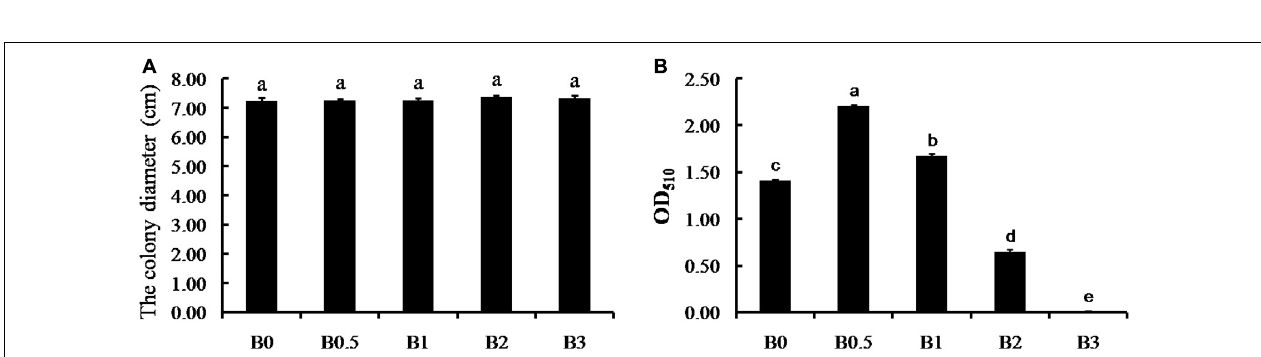
FIGURE 7 | In vitro direct effect of biochar on pathogen and antagonistic bacteria. Panels (A,B) shows the direct effect of biochar on F. solani strain FSPN-101 and B. subtilis strain BCPN-101, respectively. B0, B0.5, B1, B2, and B3 represents biochar amendment at a concentration of 0, 0.5, 1, 2, and 3% (w/v). Error bars indicate the standard error, and the different letters above the bars showed significant differences ( p < 0.05; n = 5).